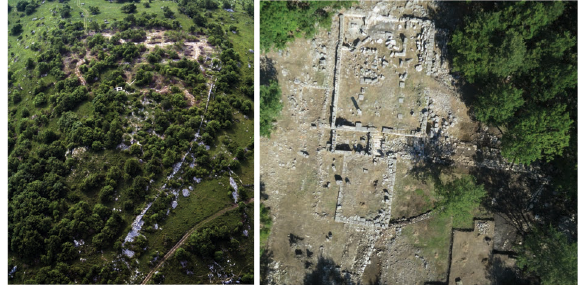
Figure 1. Terravecchia (a) and San Pietro di Cantoni (b)